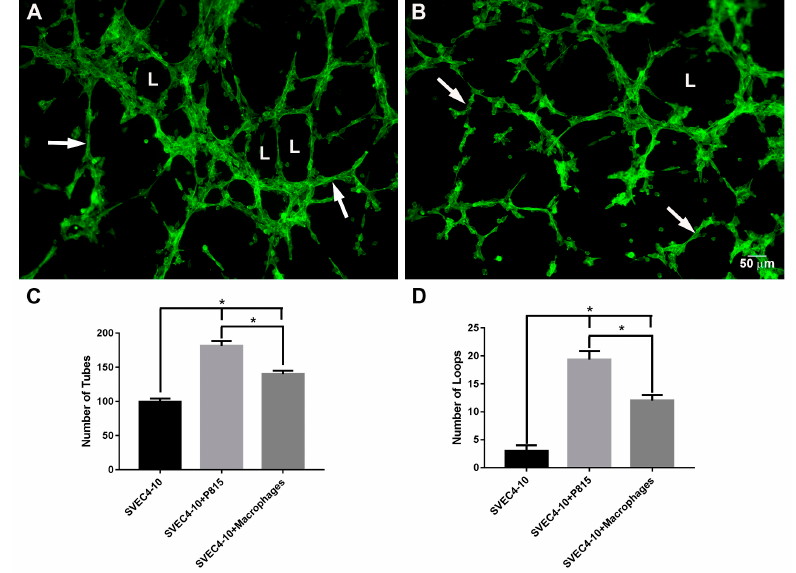
Figure 2. Mast cells are more effective in inducing tube formation than macrophages. ( A ) SVEC4-10 cells co-cultured with P815 mast cells; ( B ) SVEC4-10 cells co-cultured with macrophages. A significant increase in the number of tubes (arrows) and loops (L) was observed during co-culture of endothelial cells with mast cells when compared with co-cultures of endothelial cells with macrophages. ( A , B ) Cells were stained with phalloidin conjugated to Alexa 488; ( C , D ) The graphs show the average number of tubes and loops after 5 h of culture. The structures were quantified using Wimasis WimTube. Data are presented as mean ± SD from five independent experiments. * p ≤ 0.05.